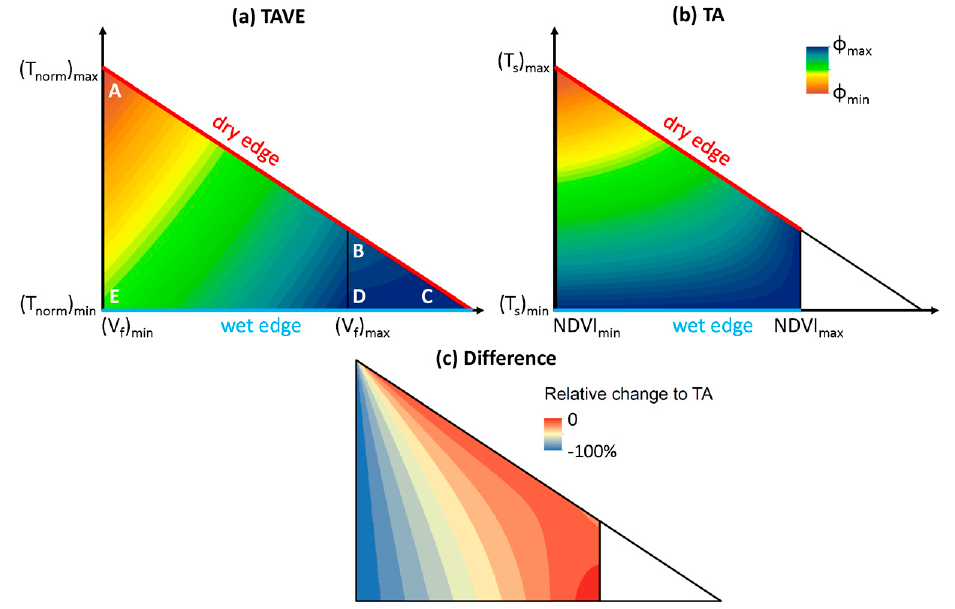
Figure 14. Comparison of the distributions of φ in temperature-vegetation triangles: ( a ) TAVE, ( b ) TA, and ( c ) the relative change to TA. The data shown are based on a hypothesized case developed for the purpose of conceptual illustration only. The notation of points A to E is provided in Figure